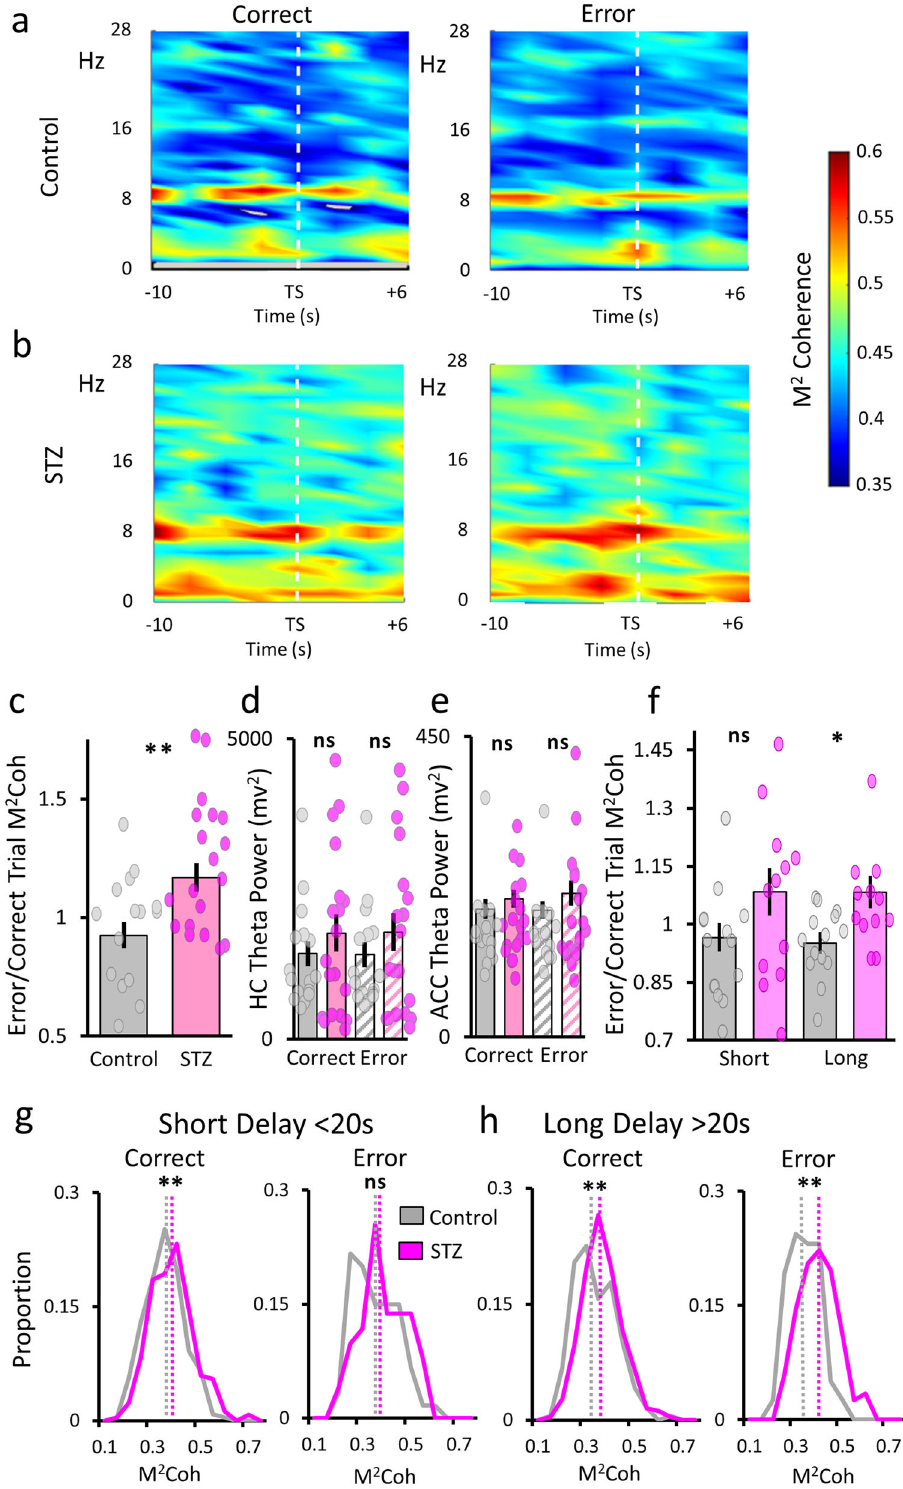
Fig. 5 Coherence during the delay period for correct and error trials. a , b Peri-event ACC – hippocampus cohereograms for correct and error trials for the control ( a ) and STZ ( b ) groups. Frequency is shown on the y -axis and time relative to trial start (TS) is on the x -axis. The z-axis legend on the far right applies to all plots. c Theta coherence trial outcome difference scores. Mean error trial coherence divided by mean correct trial coherence per session. d , e Theta band power in the hippocampal and ACC. Spectral power is on the y -axis and group and trial outcome on the x -axis. Correct trials: solid bars; error trials: striped bars. f Coherence difference scores by delay length. g , h Distribution of theta coherence values for short ( g ) and long ( h ) delay trials. Control and STZ groups on correct (left) and error (right) trials. Magnitude squared coherence is on the x -axis and proportion of trials is on the y -axis. Dotted lines show the median coherence value. In all plots, control values are in gray and STZ are shown in magenta. ** p < 0.01; * p < 0.05. Error bars =